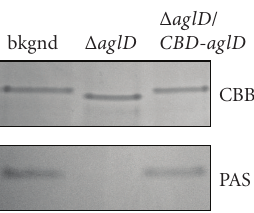
Figure 1: aglD -complemented Hfx. volcanii cells regain the ability to properly glycosylate the S-layer glycoprotein. The protein contents of cells of the WR536 background strain (bkgnd), the same strain deleted of aglD ( Δ aglD ) or the AglD-lacking strain transformed with a plasmid encoding CBD-AglD ( Δ aglD/CBD- aglD ) were separated by 5% SDS-PAGE and the S-layer glycoprotein was detected by Coomassie stain (CBB) or periodic acid-Schi ff (PAS) reagent. In the presence of CBD-AglD, the migration and positive glycostaining of the S-layer glycoprotein are as observed in the background